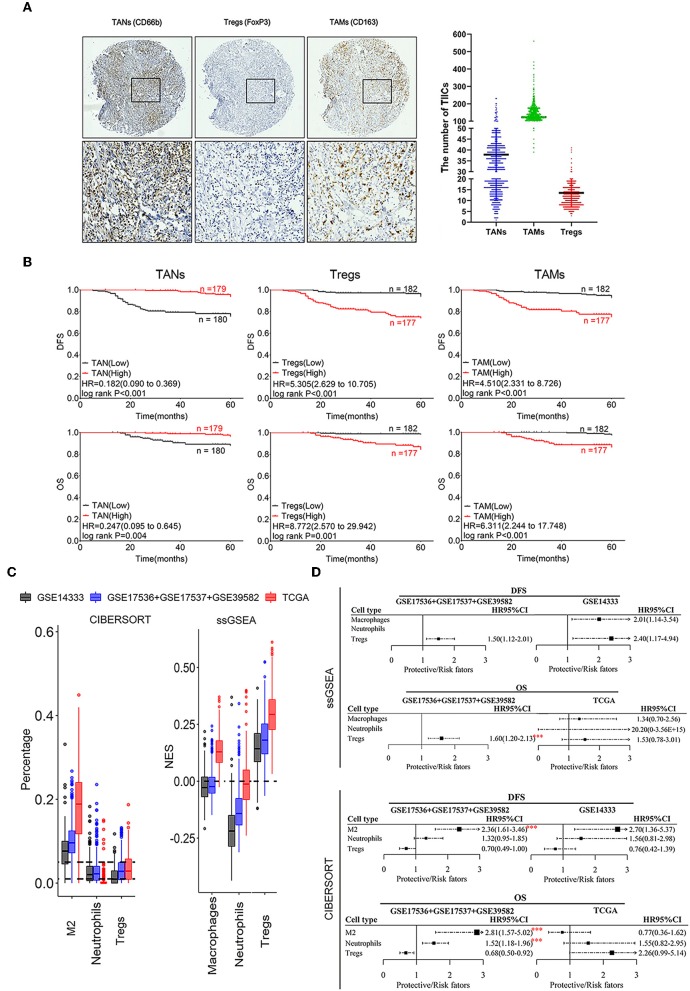
Correlation of infiltrating TANs, TAMs, and Tregs with prognosis in CRC patients. (A) The IHC images were taken at 100 (upper panel) and 400 (lower panel) magnification. (B) Association of the number of infiltrating TANs, Tregs, TAMs with CRC prognosis. (C) Infiltration of TANs, TAMs, and Tregs transformed by using ssGSEA and CIBERSORT. The relative numerical values corresponding to the height of the histogram indicate the different levels of abundance and the proportions. (D) Survival analysis: HR results from Cox univariate analysis with the transformed data based on ssGSEA and CIBERSORT tools. ***P ≤ 0.001.